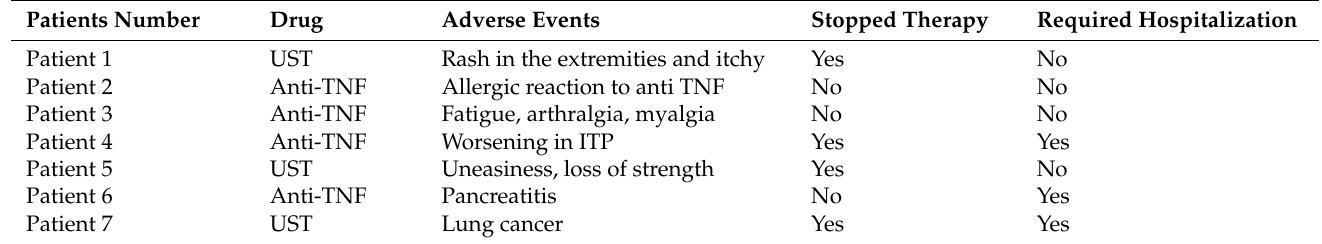
Table 2. Adverse